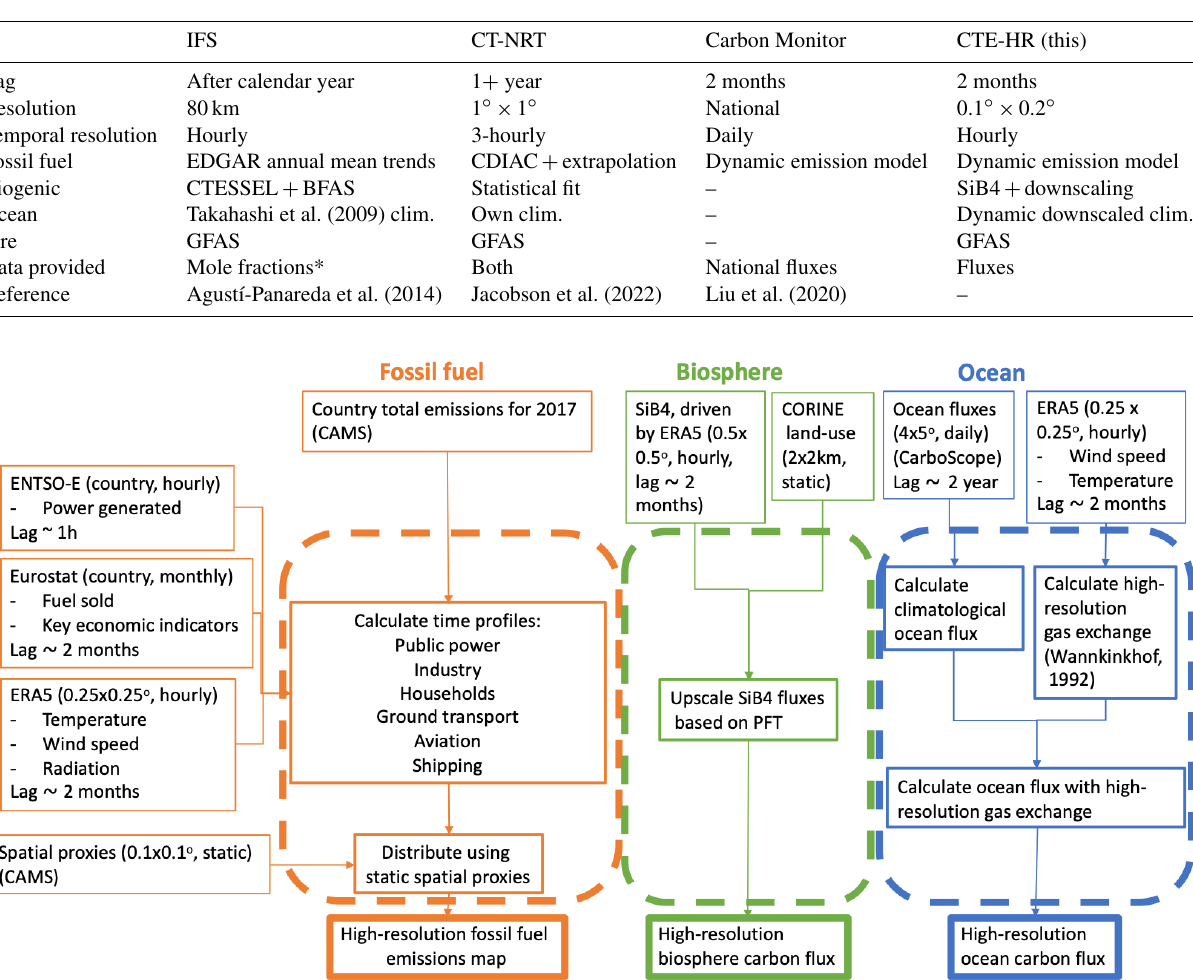
Figure 1. Flow chart of incoming data streams and their use in CTE-HR. The orange box shows the fossil fuel module, the blue box shows the data used for downscaling the ocean fluxes and the green box shows the calculation of the high-resolution biosphere fluxes. With all dynamic incoming data streams, the resolution and lag are shown. The individual products, such as CAMS, are described in the